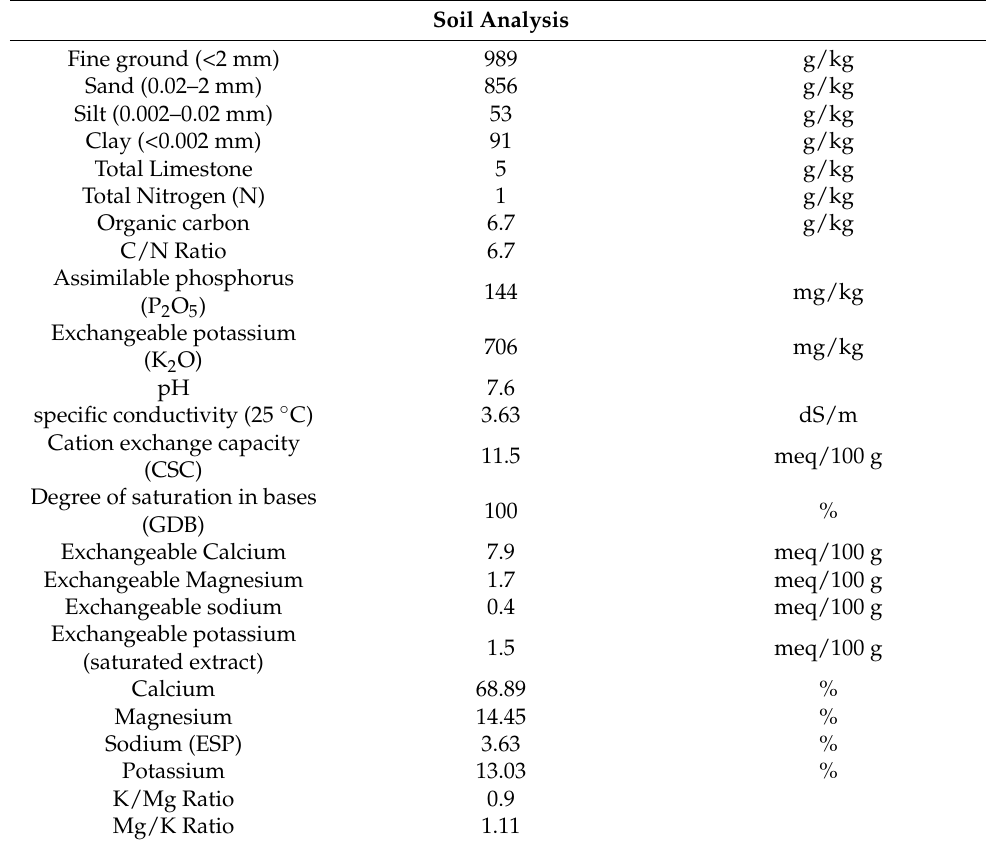
Table 1. Soil analysis of the experimental fi eld .